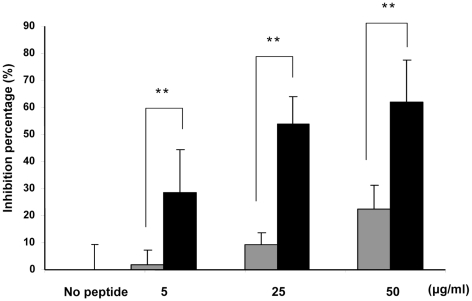
Gp41 TMD inhibits T-cell proliferation in vitro.T-cells were activated with the MOG 35–55 peptide and APC in the presence of gp41 TMD (black) or FP5–13 AAAA as control peptide (grey) in three different concentrations (50, 25 and 5 µg/ml) and the proliferative responses were assayed. The data are presented as mean inhibitions+SD (n = 4 or more, ** p<0.01). The uninhibited T-cell proliferative responses were 9382±891 cpm. The background proliferation in the absence of antigen was 232±36 cpm.